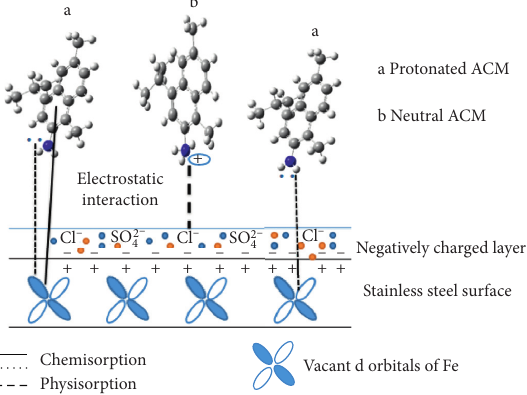
Figure 10: Schematic diagram of the adsorption process of ACM on the SS